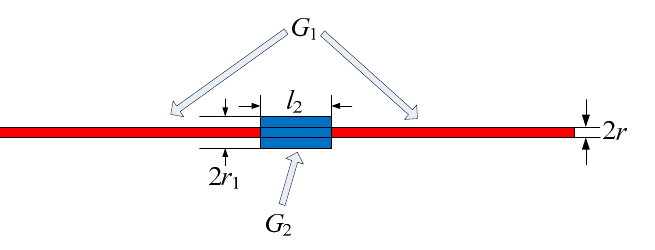
Figure 5. Schematic diagram of conductor losses in three-core joint considering contact resistance.